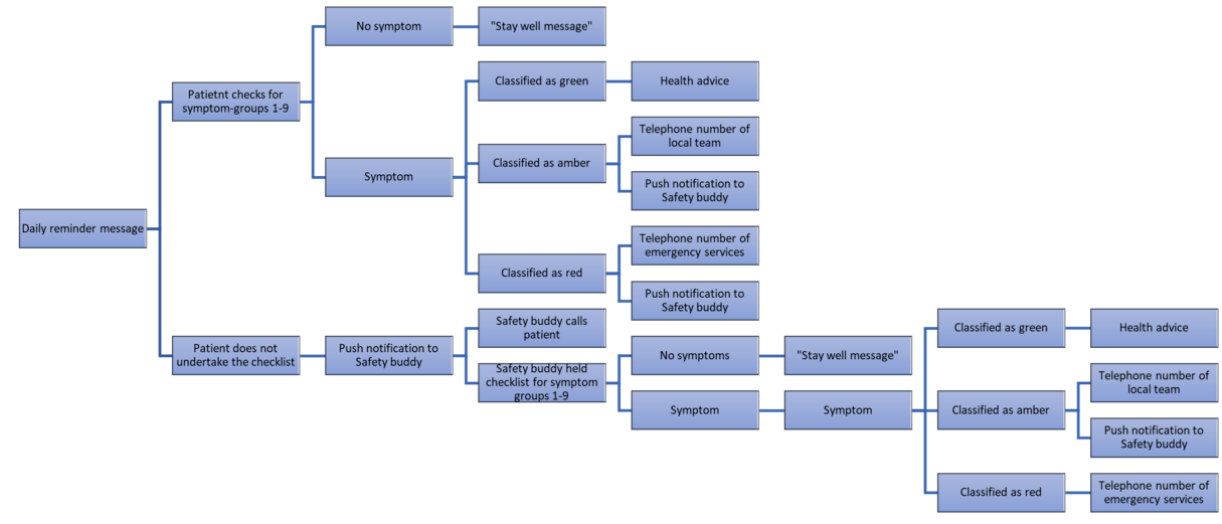
Figure 2. Workflow of the